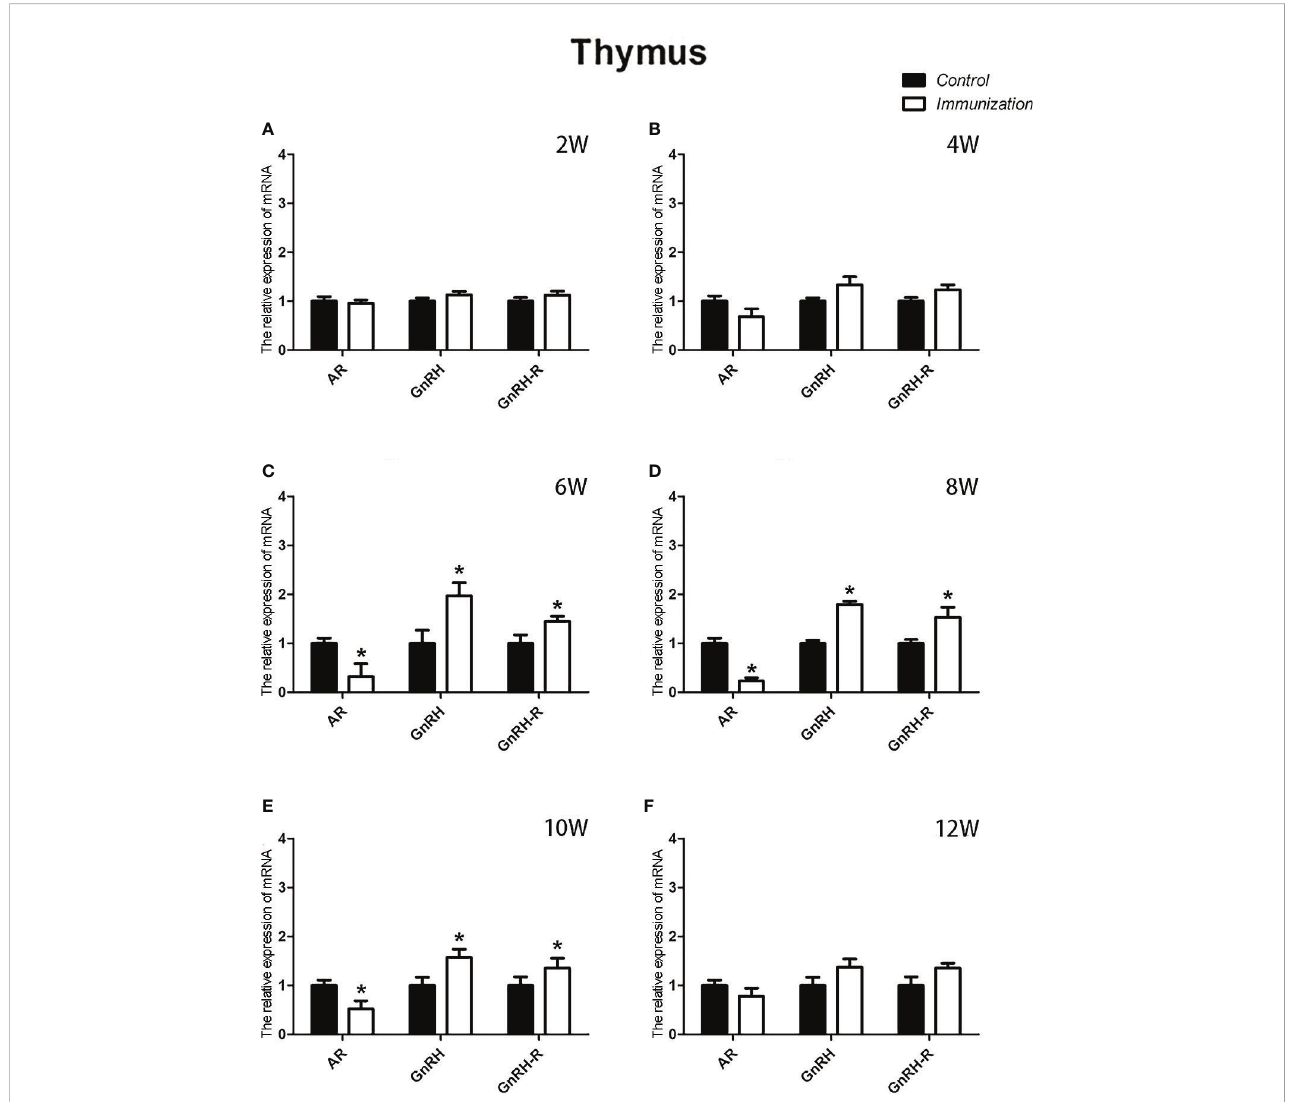
FIGURE 6 Mean (± SEM) of the effects of gonadotropin-releasing hormone (GnRH) immunization on the mRNA expression of reproduction-related genes in the thymus of the control (n = 35) and GnRH immunization (n=35) groups. (A – F) indicate the detection time at different ages. * Indicates a signi fi cant difference ( P <